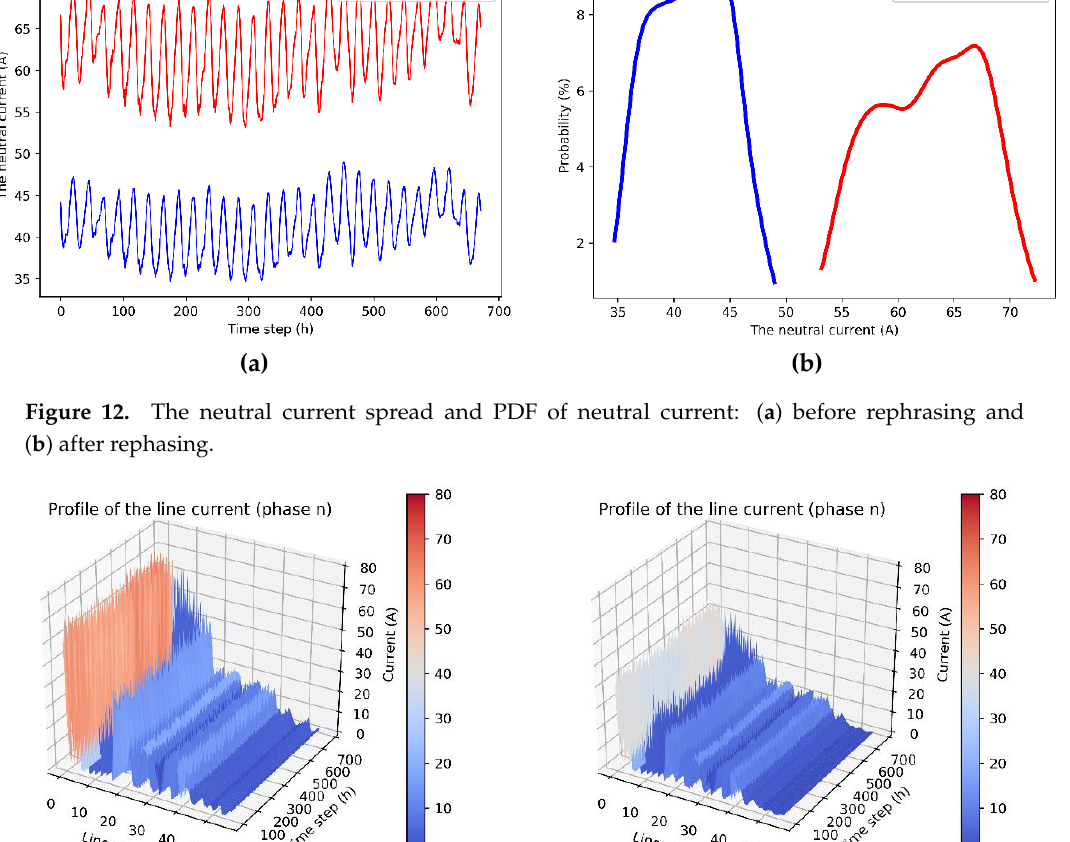
Figure 13. The neutral current profile in each line section: ( a ) before rephrasing and ( b ) after rephasing.